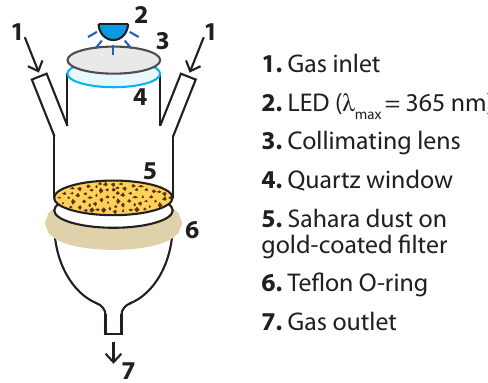
Fig. 1. Reactor used to investigate fractionation during oxidation of SO 2 on mineral dust.